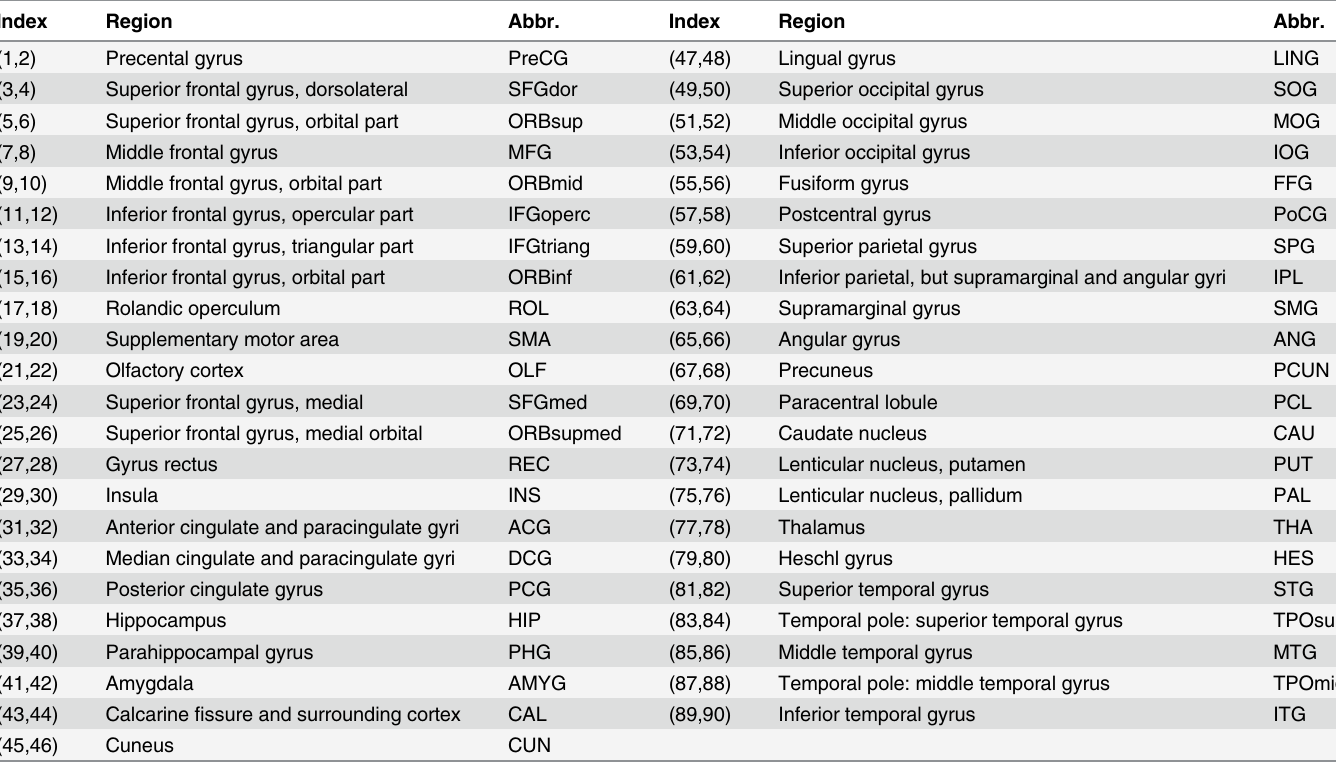
Table 1. Cortical and subcortical regions of interest defined in study.